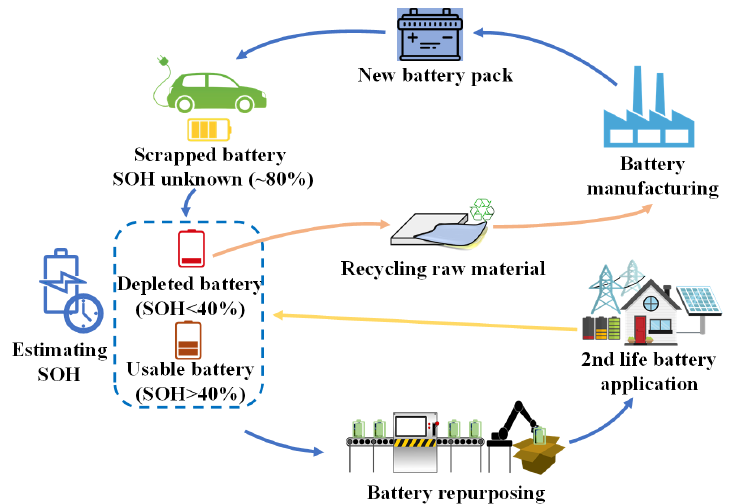
Figure 1. The life cycle of a battery with second ‐ life use.